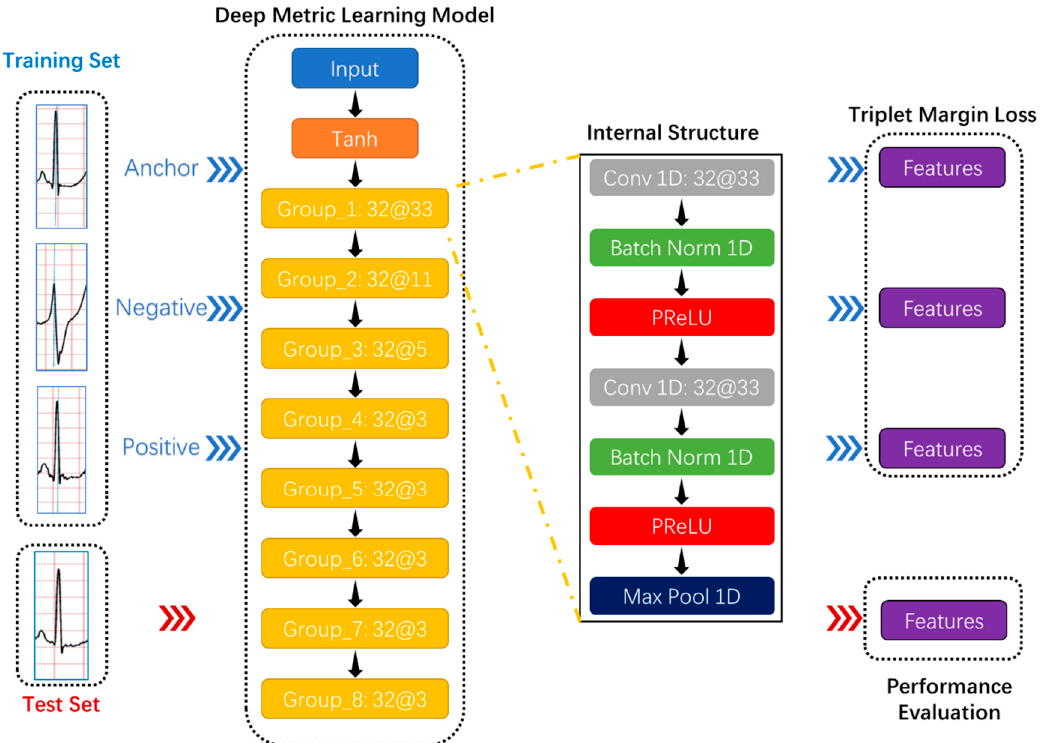
Figure 4. The proposed deep metric learning model’s basic architecture. Take “Group_1 32@33” as an example to comprehend the convolution group. “Group _1” is the convolution group’s name; “32@33” represents the number and size of the one-dimensional convolutional layer’s convolution kernels in the convolution group. Each convolutional group contains two 1D convolutional layers, two batch normalization layers, two activation functions, and one max-pooling layer.